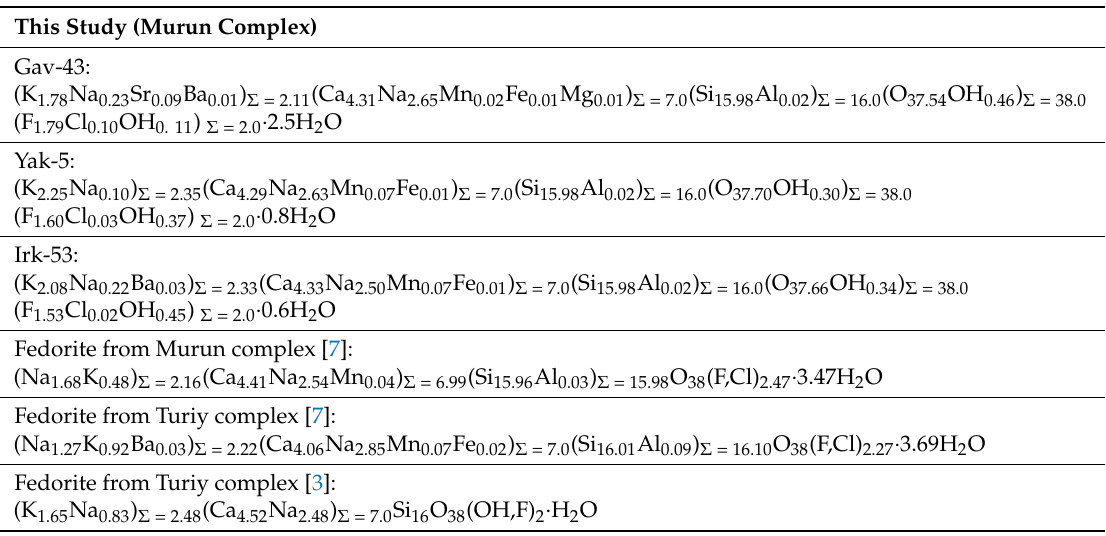
Table 3. Crystal chemical formulas of the studied and literature